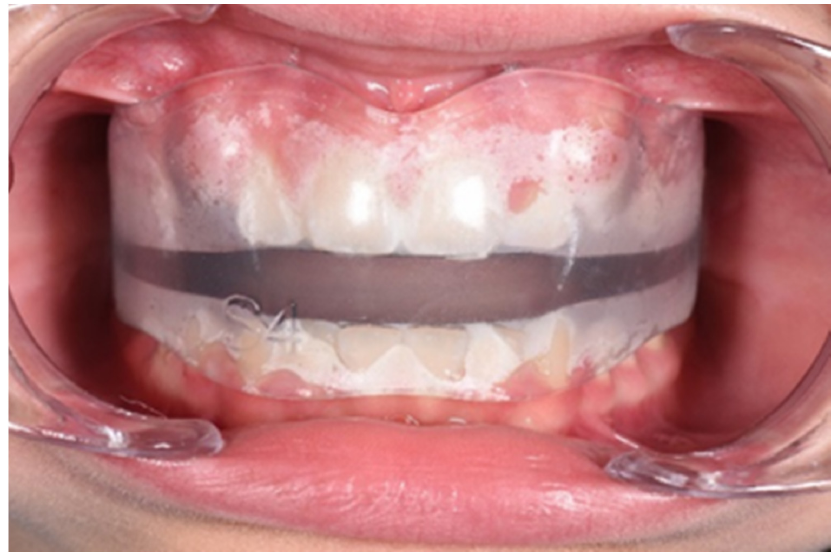
Figure 1. AMCOP devices available on the market.